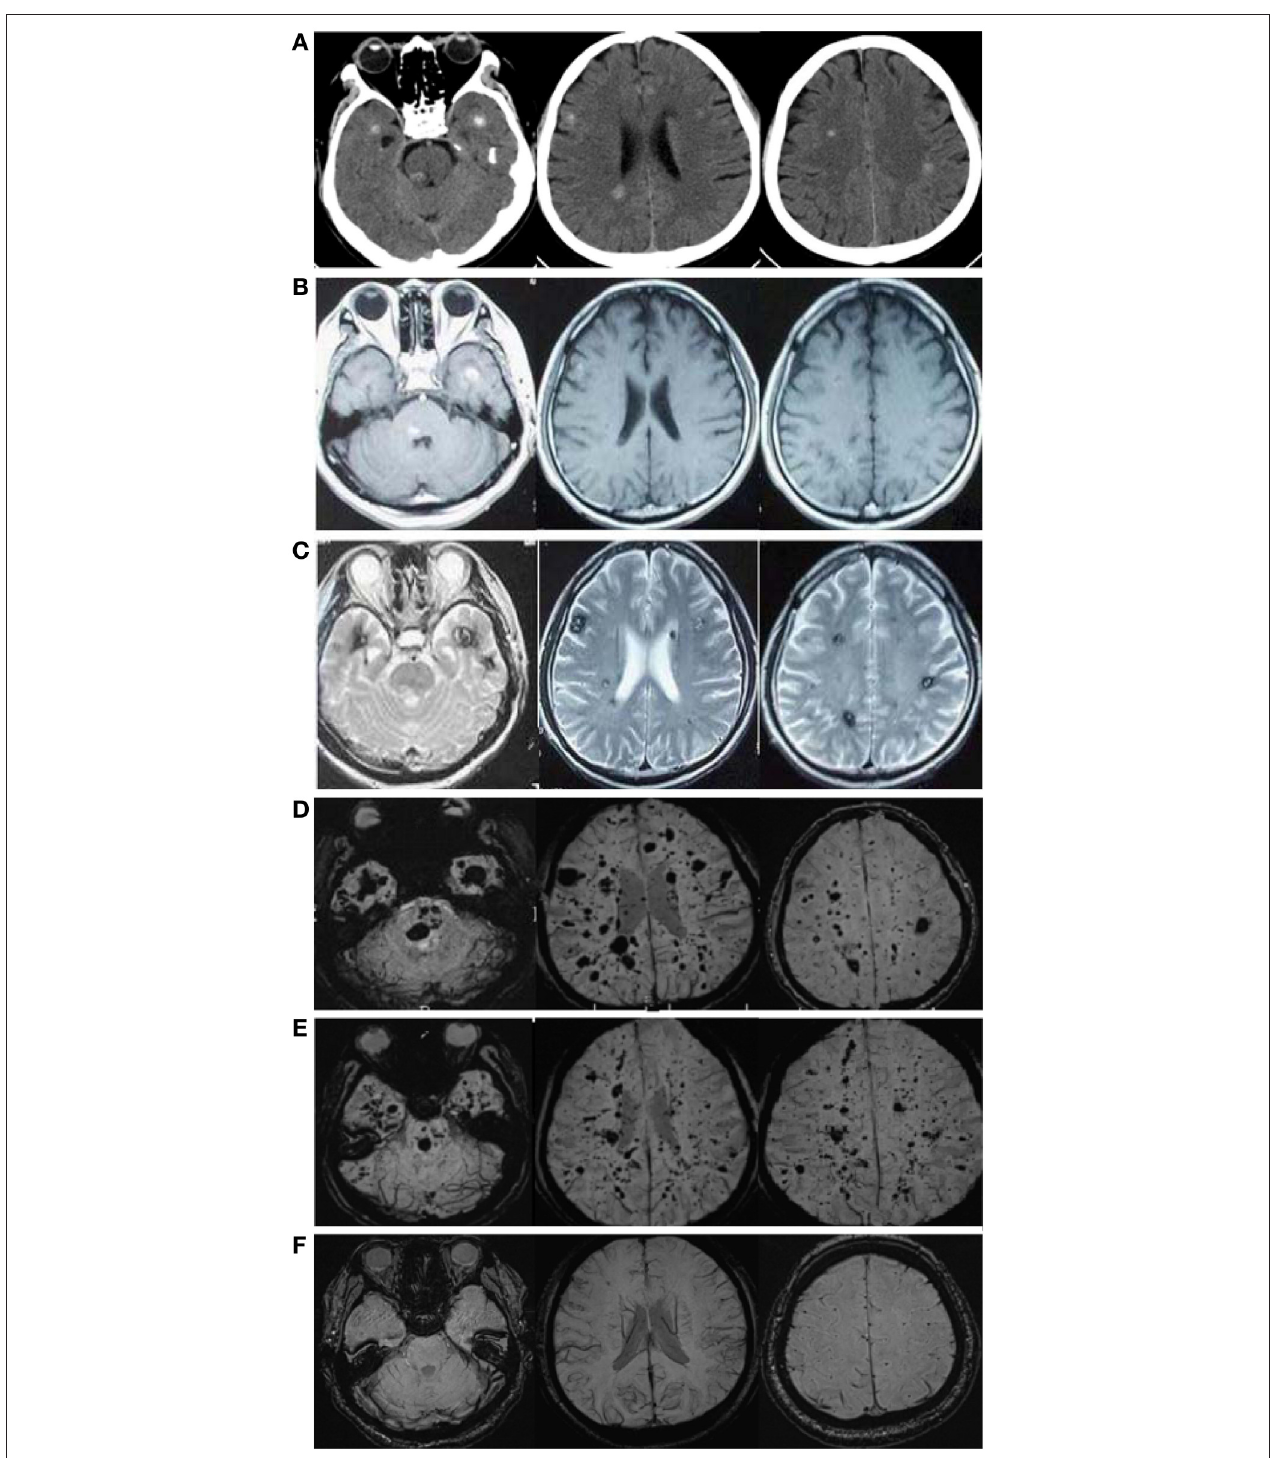
FIGURE 2 | CCM lesions diagnosed through CT, GE-and SWI-MRI. (A) CT of the 57-year-old proband, II-1. A plain CT scan (brain window images) showed multiple calcification spots scattered on the tegmentum of the pons, temporal lobes and periventricular area. (B) Axial T1-weighted gradient-echo (GE) MR imaging of the proband, II-1. Axial T1-weighted GE images demonstrated hyper-intensity of hemorrhage lesions. (C) Axial T2-weighted gradient-echo (GE) MR imaging of the proband, II-1. T2-weighted GE images showed a “popcorn” appearance surrounded by a dark rim of hemosiderin. (D) SWI-MR imaging of the proband, II-1.